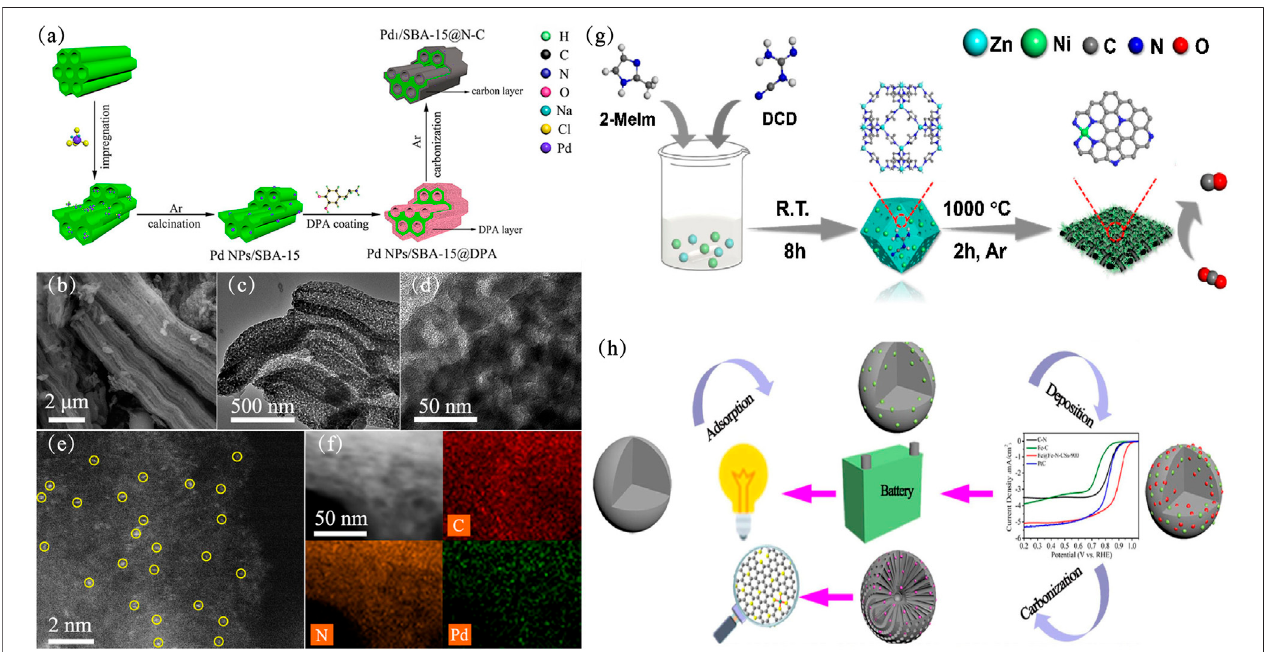
FIGURE5| TheconstructionandcharacterizationofPd 1 /SBA-15@N-C(a-f)(Lietal.,2021).Copyright2021,AmericanChemicalSociety. (A) Syntheticprocedure of Pd 1 /SBA-15@N-C. (B) SEM, (C) TEM, (D) HR-TEM, and (E) AC HAADF-STEM images of Pd 1 /SBA-15@N-C. (F) Elemental mapping of Pd 1 /SBA-15@N-C. (G) synthesis procedure of Fe at Fe-N-CSs electrocatalyst (Lu et al., 2019). Copyright 2019, Elsevier. (H) Scheme for the synthesis of Ni SAs/NCNTs (Chen et al., 2020b). Copyright 2020, Elsevier.